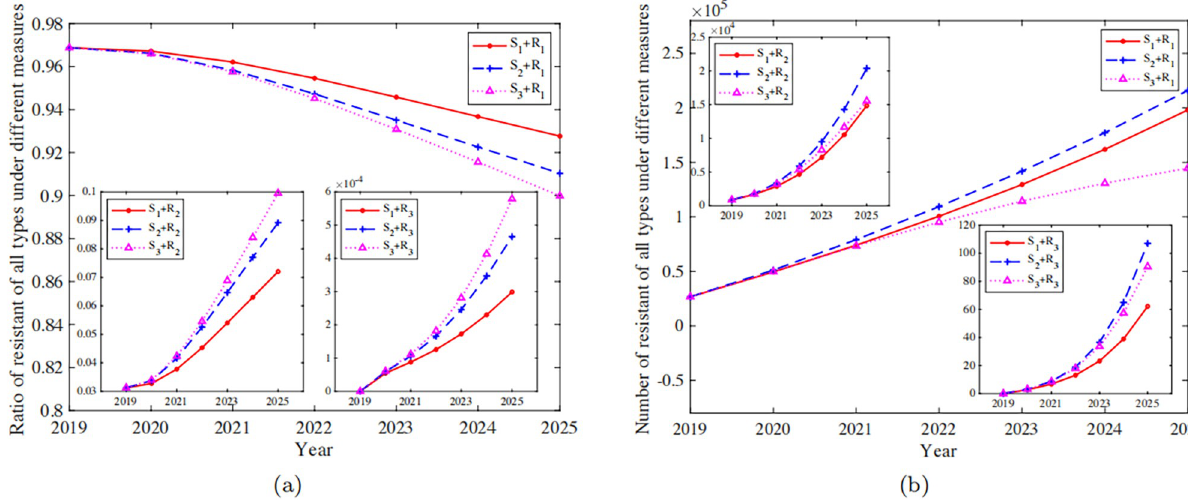
Fig 5. The multi-drug resistance dynamic under different intervention measures. a: The resistance rate of all types under different measures. b: The resistance number of all of all types under different measures.